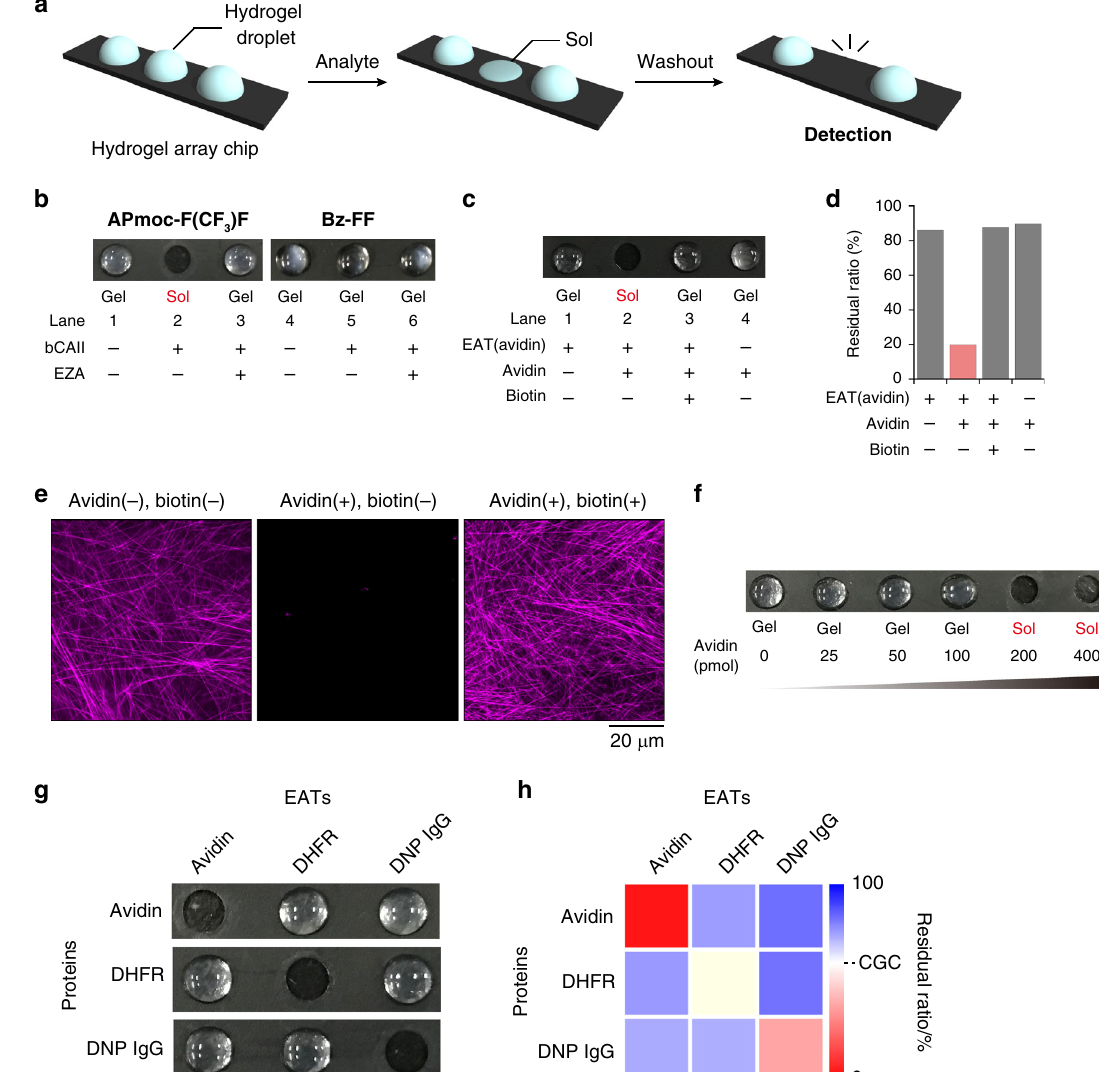
Fig. 2 bCAII and protein responses of supramolecular hydrogels. a Schematic illustration of naked eye detection of a gel – sol transition triggered by bCAII and non-enzymatic proteins on a hydrogel array chip. b bCAII response of (left) APmoc-F(CF 3 )F and (right) Bz-FF . EZA: ethoxzolamide. Condition for bCAII response: [ APmoc-F(CF 3 )F ] = 0.35 wt% (6.1 mM), [ Bz-FF ] = 2.0 wt% (42 mM), [bCAII] = 10 µ M, [EZA] = 100 µ M, 100 mM HEPES (pH 8.0), 25 ° C, 6 h, V gel : V stimulus = 10:1. c Avidin response of APmoc-F(CF 3 )F hydrogels containing bCAII and EAT(avidin) . d Residual ratios of APmoc-F(CF 3 )F